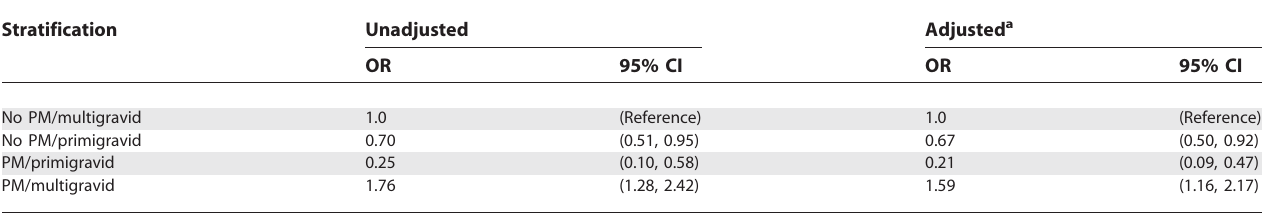
Table 3. Unadjusted and Adjusted Odds of Any Parasitemia during Infancy Associated with Placental Malaria, Stratified by Gravidity